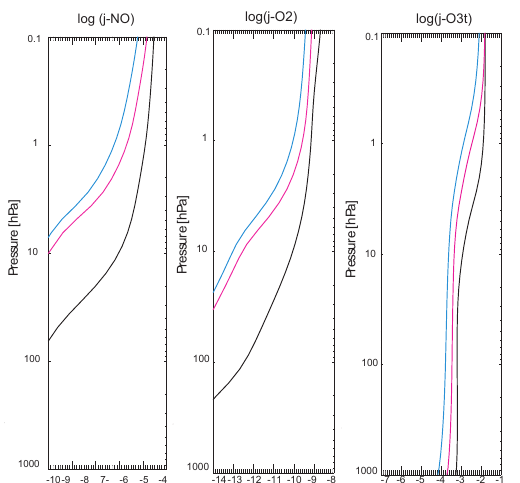
Fig. 1. Photolysis rates for the CCMVal photolysis assessment sce- narios for NO (left), O 2 (centre) and O 3 (right). The three lines correspond to a solar zenith angle of 15 ◦ (black), 84 ◦ (pink) and averaged over a day between 84 ◦ and 96 ◦ (blue). This figure can be compared to Fig. 6.1 in Chipperfield et al. (2010).